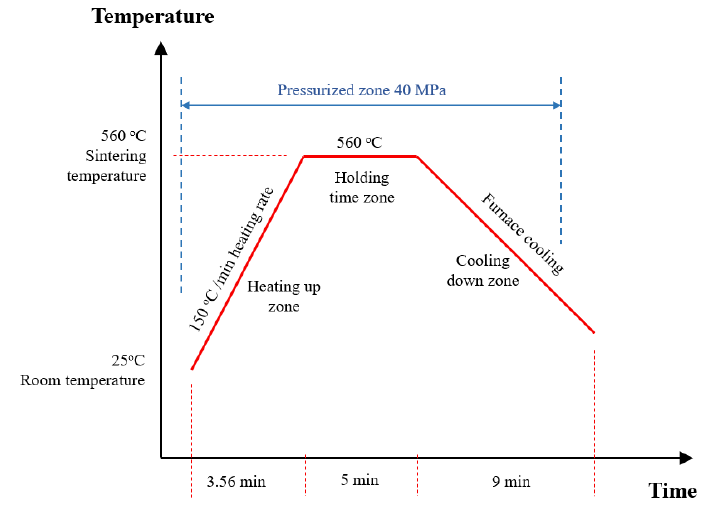
Figure 2. Consolidation process heat map.